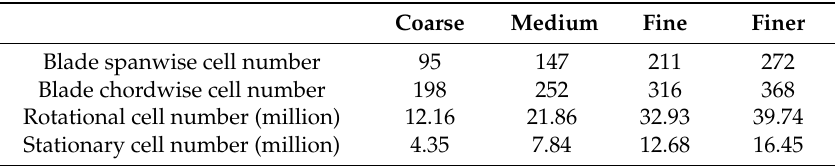
Table 2. Details of computational mesh for grid dependency